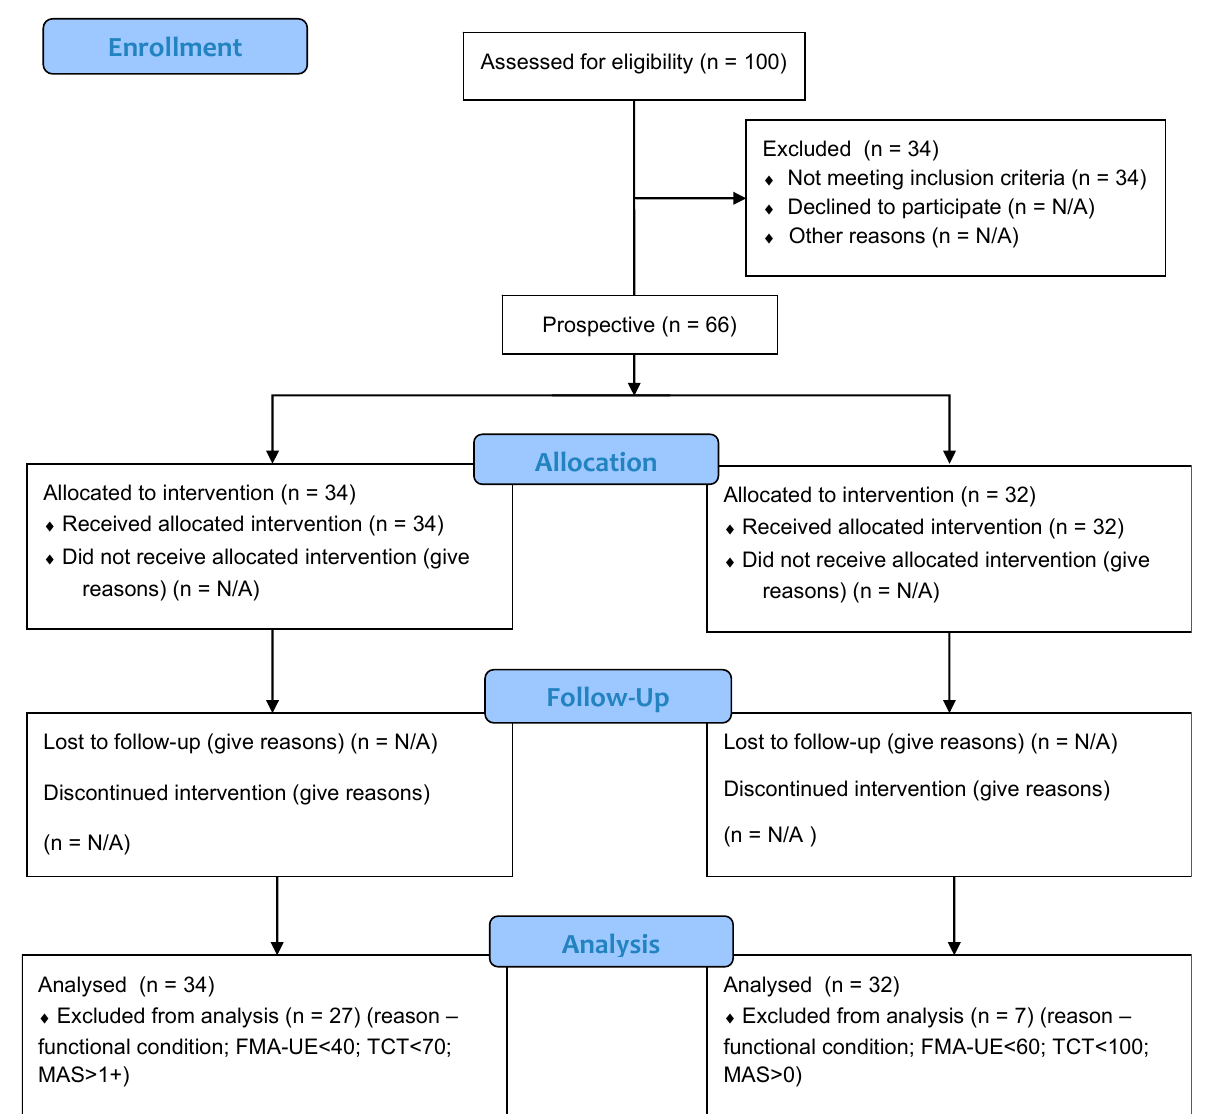
Figure 1. Flow of participants through each stage of the study.